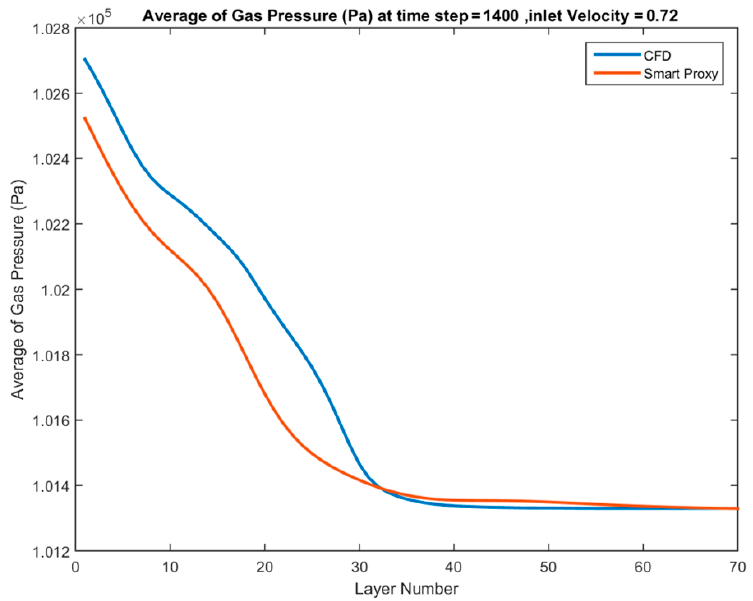
Figure 33. Spatially averaged CFD and smart proxy results for gas pressure (Pa) at time step = 1400 for blind test condition of V in = 0.72 m/s (with four static parameters). Fluids 2019 , 4 , x